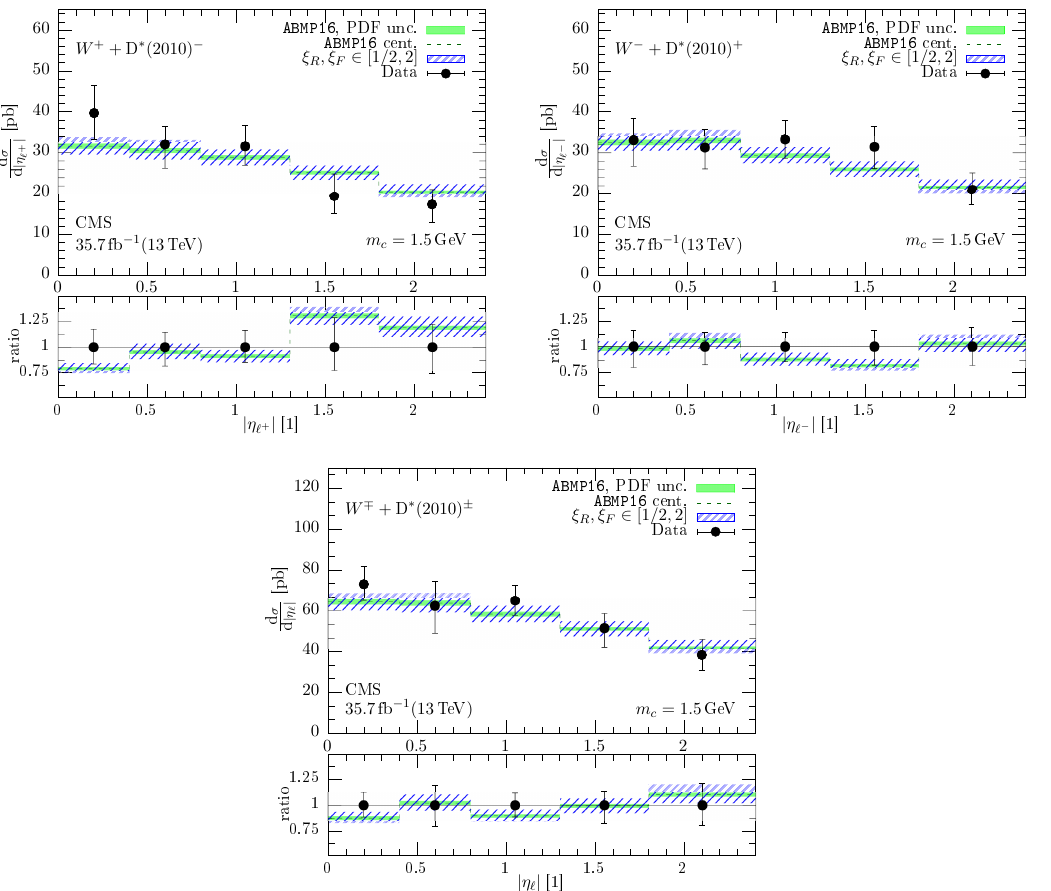
Figure 4 . Same as in figure 3, but using the PYTHIA8 ATLAS A14 central tune with NNPDF2.3LO PDFs.